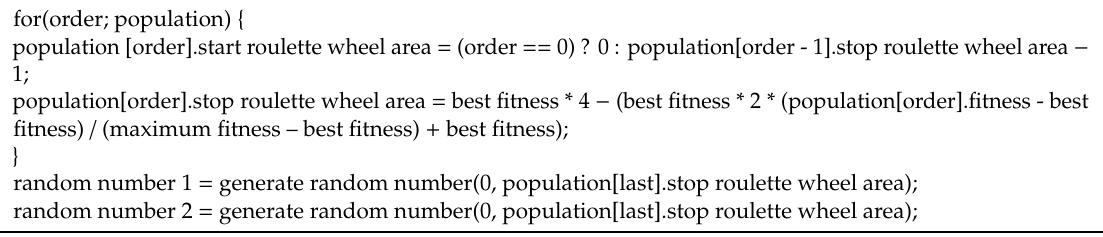
Table 9. Pseudocode for selection [6].